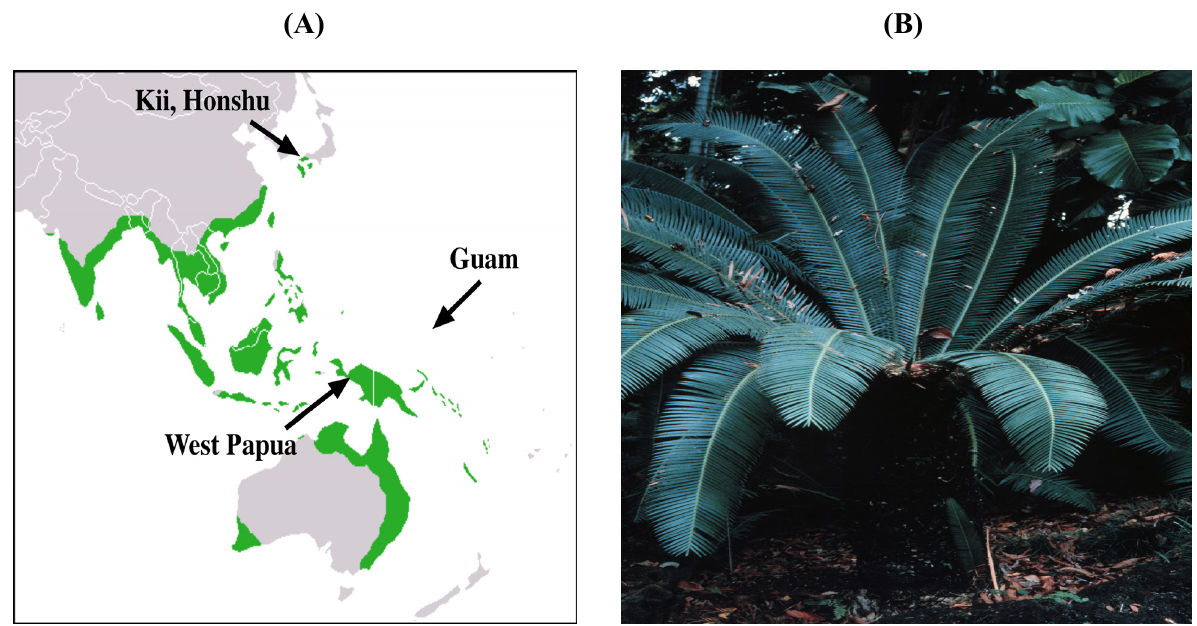
Figure 1. Cycad distribution in the western Pacific region ( A ) and photograph of a Cycas circinalis plant ( B